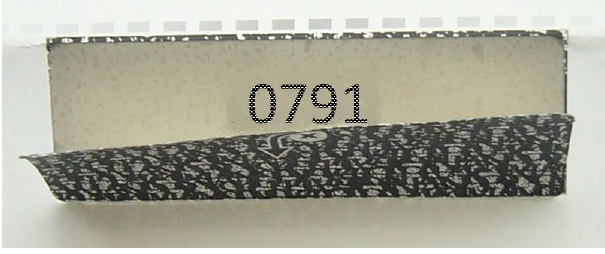
Figure 4. A PIN sent to a client in a letter. The darkened paper flap prevents the number from being read by holding the unopened envelope to a light (public domain image derived from a real photo). Sending of such a PIN via a VC scheme can be a more secure alternative (e.g., sent of deferred envelopes with VC shares).